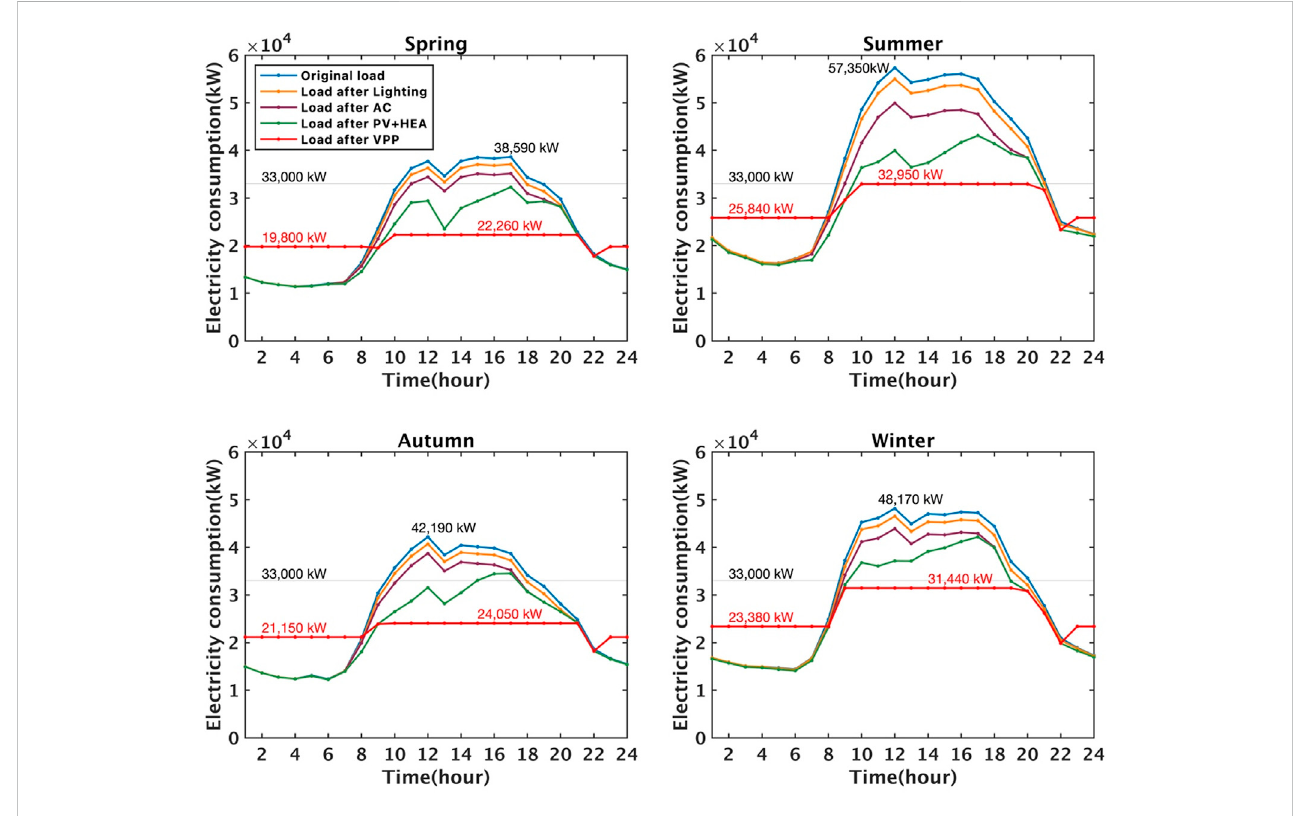
FIGURE 8 Peak-shaving effect of VPP on a typical day of each